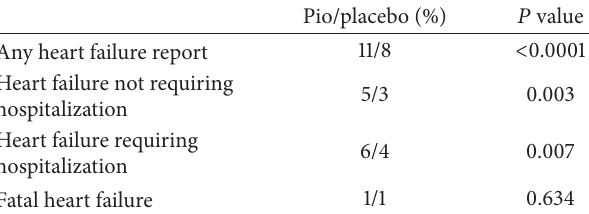
Table 2: PROactive heart failure data [4].